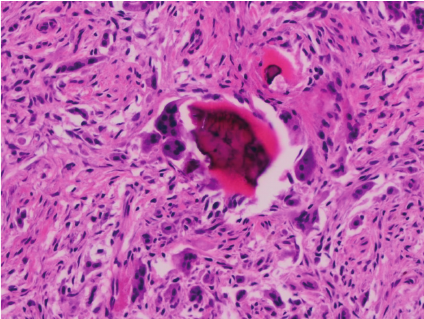
Figure 6: Medical model demonstrating the extent of the expansion of this